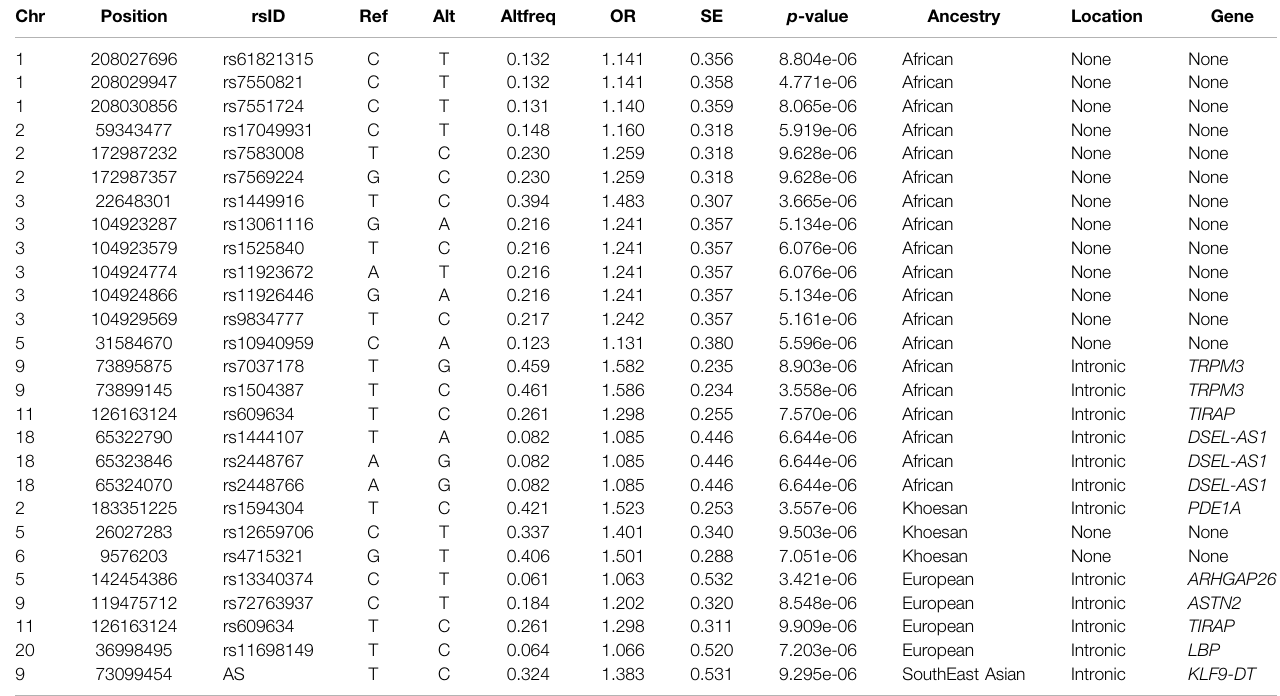
TABLE 3 | Summary statistics of the top results ( p -value < 1 × 10 − 5 ) whilst utilising the Local Ancestry Adjusted Allelic (LAAA) model. Chr Position